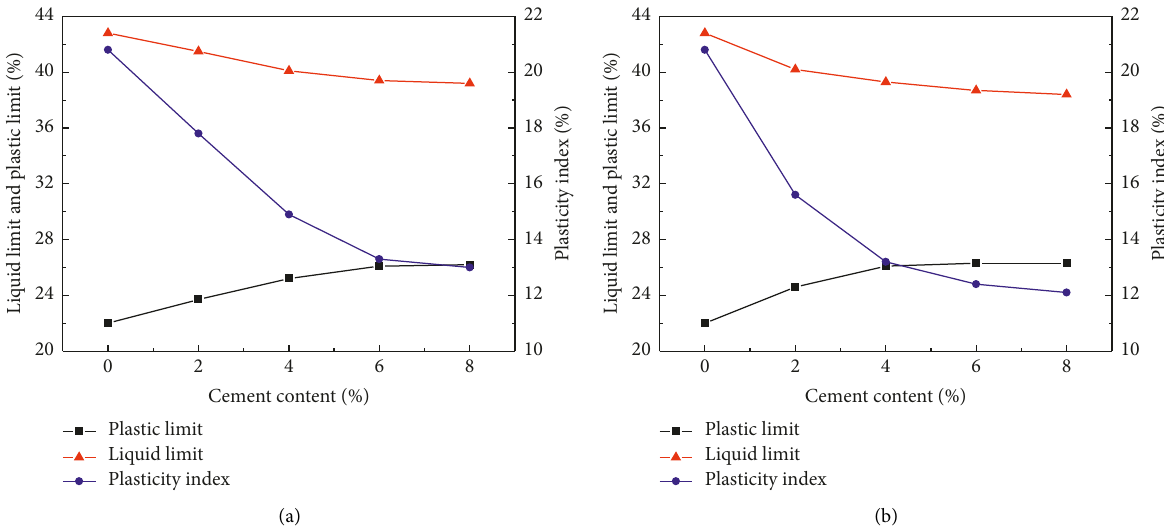
Figure 7: The Atterberg limits of cement-stabilized soil under different curing periods. (a) 7 days. (b) 28